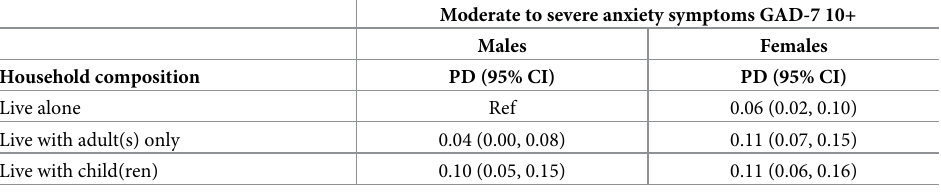
Table 4. Prevalence differences for the association between household composition and anxiety symptoms (GAD- 7 10+) modified by gender.